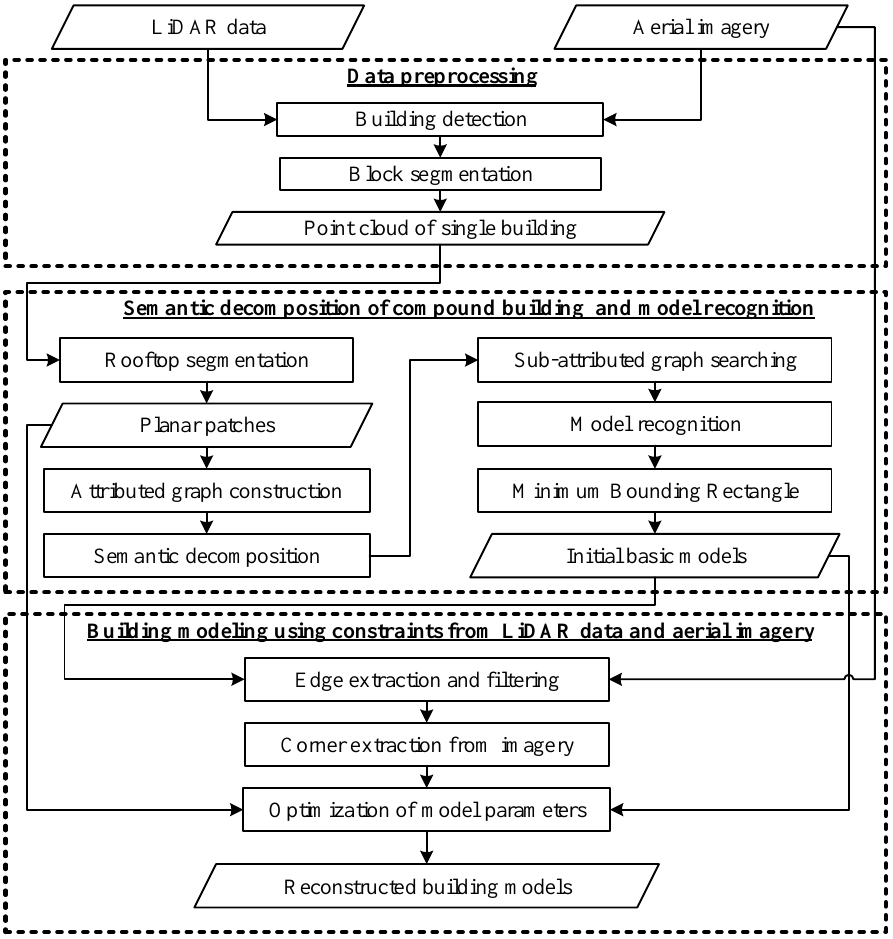
Figure 1. Flowchart of the proposed compound building decomposition and reconstruction